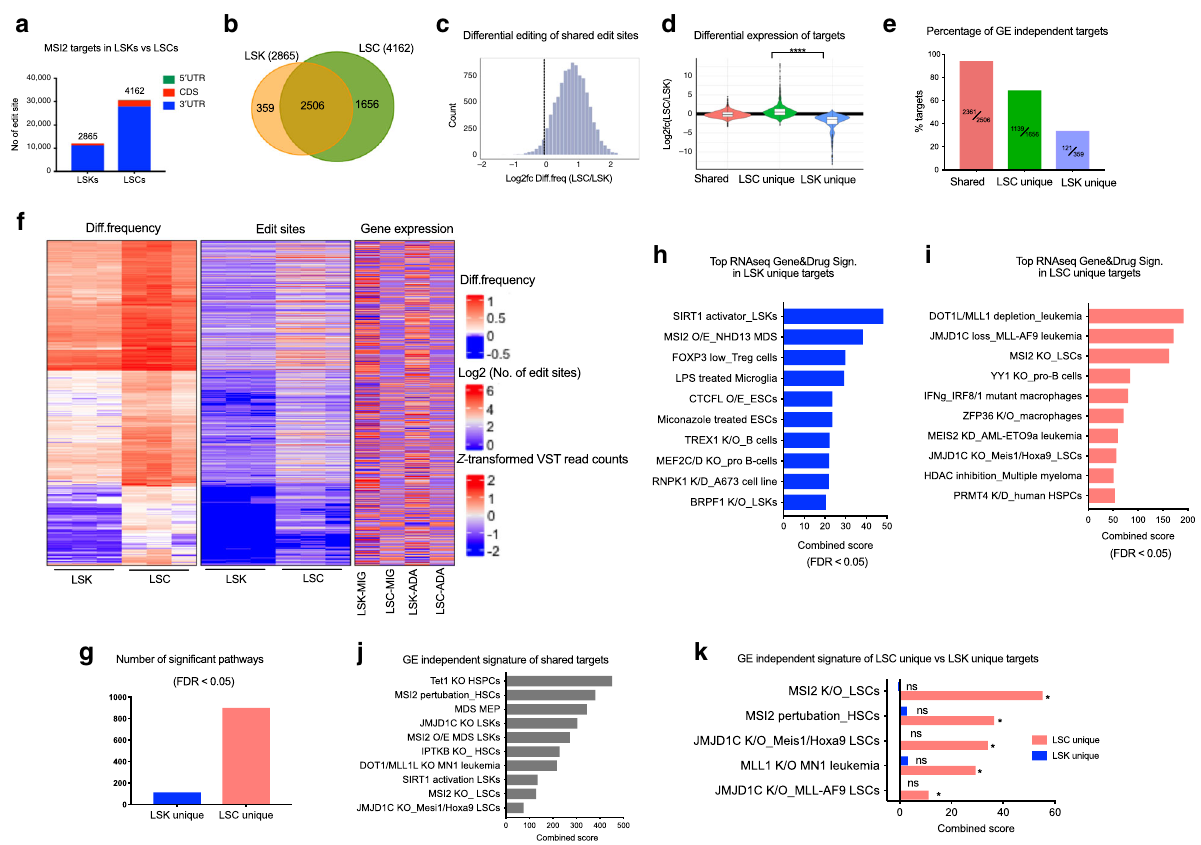
Fig. 3 Increased MSI2 RNA binding activity in LSCs. a Number of MSI2-HyperTRIBE signi fi cant edit sites and their distribution on genes in LSKs and LSCs. Number of target genes in each cell type is shown on top of the bars. n = 3. b Overlapping of target genes in LSKs and LSCs: 2506 shared, 1656 LSC unique targets, and 359 LSK unique targets. c Differential editing of shared sites, represented by Log2 fold change of diff.frequency in LSCs and in LSKs. d Violin plot presenting log2 fold change of gene expression in LSCs and LSKs (overexpressing MIG) of shared targets, LSC unique targets ( n = 1651) and LSK unique targets ( n = 359). One-sided Wilcoxon test. **** p < 0.0001. Plot center lines show the median, box limits denote upper and lower quartiles, whiskers represent 1.5× interquartile range and individual points show outliers. e Percentage of gene expression (GE) independent targets in shared, LSC unique and LSK unique target groups from b . f Clustering of diff.frequency for top gene targets with diff.frequency of at least 0.6 in LSKs and LSCs (left panel). Only genes with diff.frequency signi fi cantly different (LSC vs LSK, beta-binomial test), are plotted. Matched number of edit sites for each target (per row) (the middle panel) and corresponding expression level in LSKs versus LSCs (right panel). g Total number of signi fi cant RNA-seq Gene and Drug signatures (FDR < 0.05) enriched in LSK and LSC unique targets. h Top signi fi cant RNA-seq Gene and Drug signatures enriched in LSK unique targets (359 genes) using ENRICHR analysis. FDR < 0.05 for all indicated pathways. i Top signi fi cant RNA-seq Gene and Drug signatures enriched in LSC unique targets (1656 genes) using ENRICHR analysis. FDR < 0.05 for all indicated pathways. j Gene expression (GE) independent RNA-seq Gene and Drug signatures of shared targets in LSKs and LSCs. Full list of shared target genes in b is fi ltered with log2fc (LSC-MIG/LSK-MIG) ≤ 1.2. k GE independent signature of RNA- seq Gene and Drug signatures of LSC unique and LSK unique targets. *FDR <